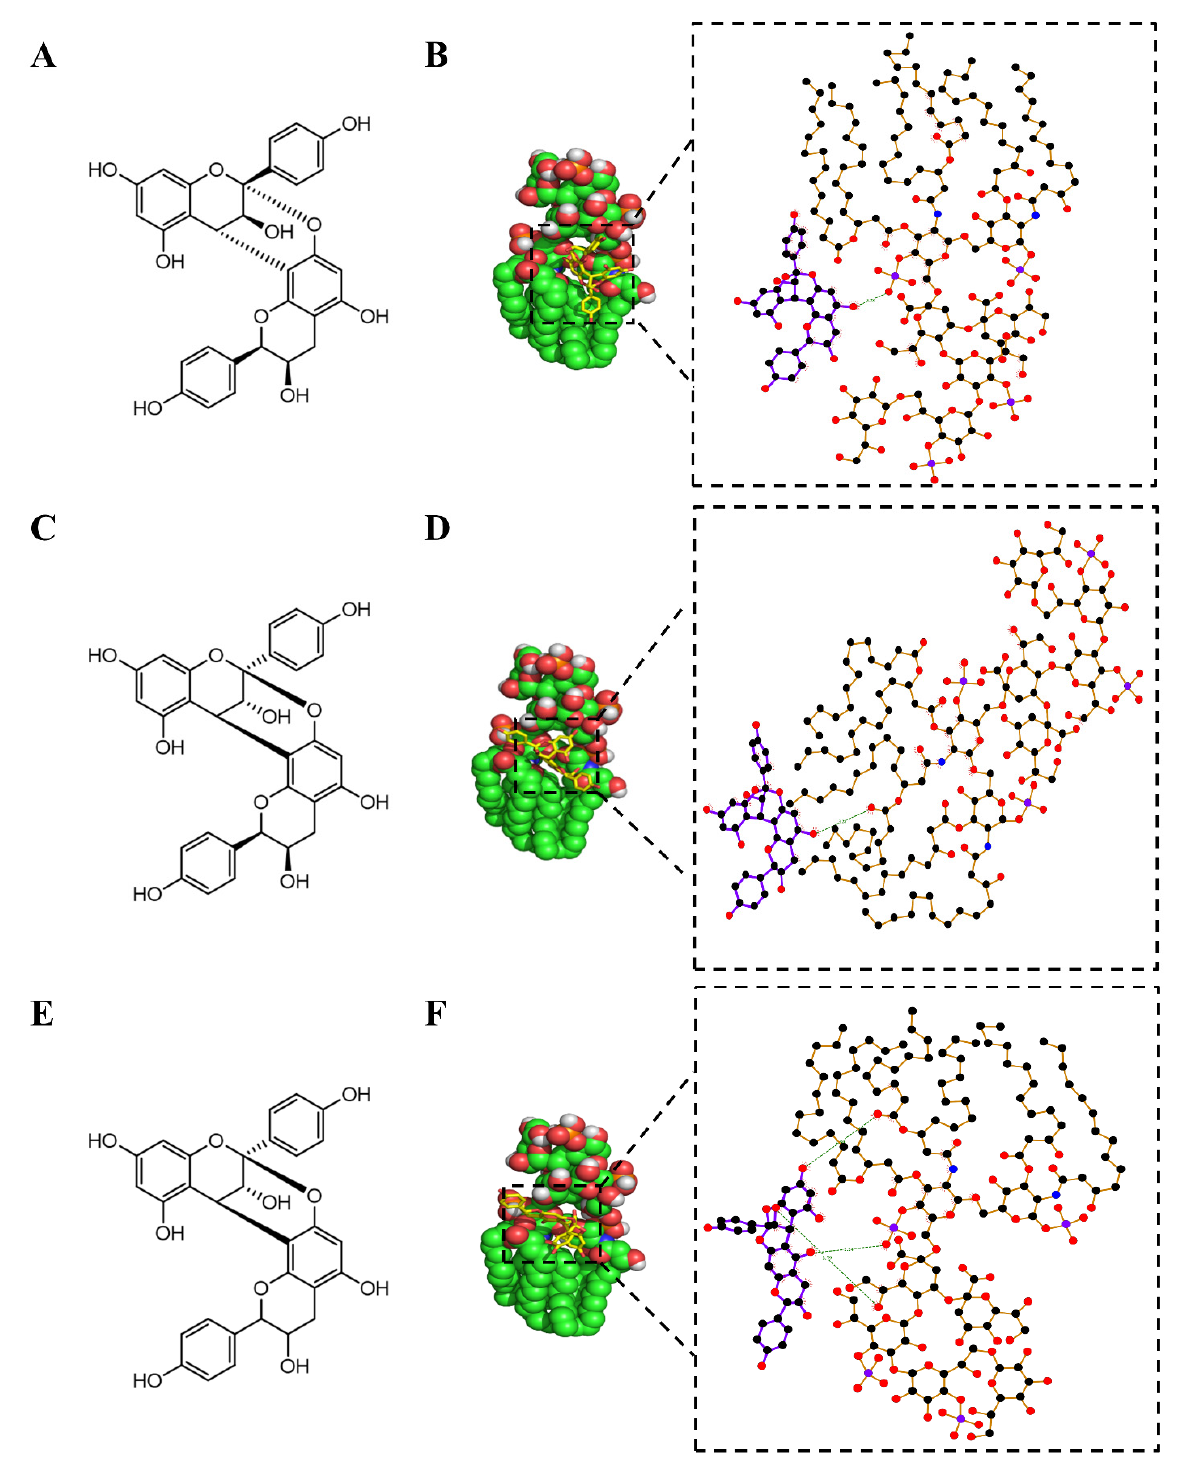
Figure 5. Computer modeling of the LPS and selected natural compounds binding. ( A ) Two-dimensional structure of Mahuannin A. ( B ) The preferred orientation of Mahuannin A in complex with LPS. ( C ) Two-dimensional structure of Mahuannin B. ( D ) The preferred orientation of Mahuannin B in complex with LPS. ( E ) Two-dimensional structure of Mahuannin C. ( F ) The preferred orientation of Mahuannin C in complex with LPS (black circles mean carbon atoms; red circles mean oxygen atoms; blue circles mean nitrogen atoms; purple circles mean phosphorus atoms; the green dashed line means hydrogen